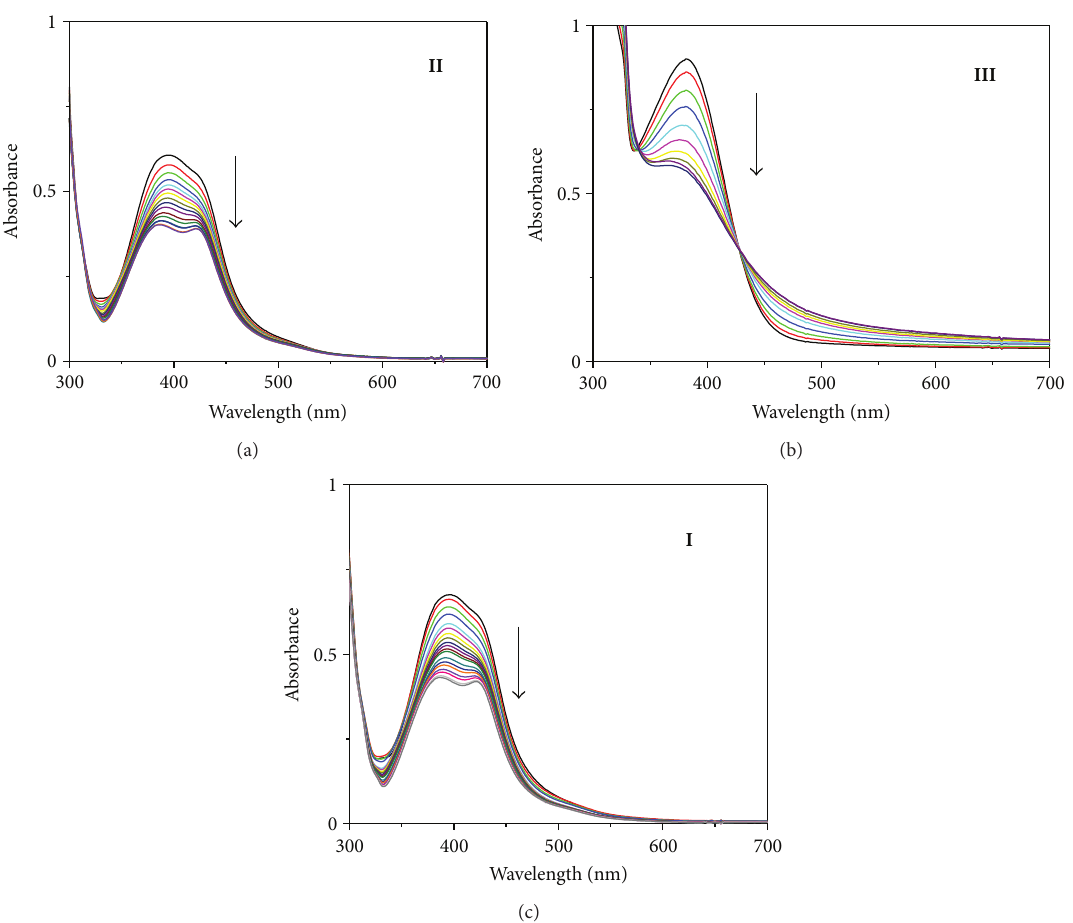
F 7: Photochemistry of complex II (1.5mM in